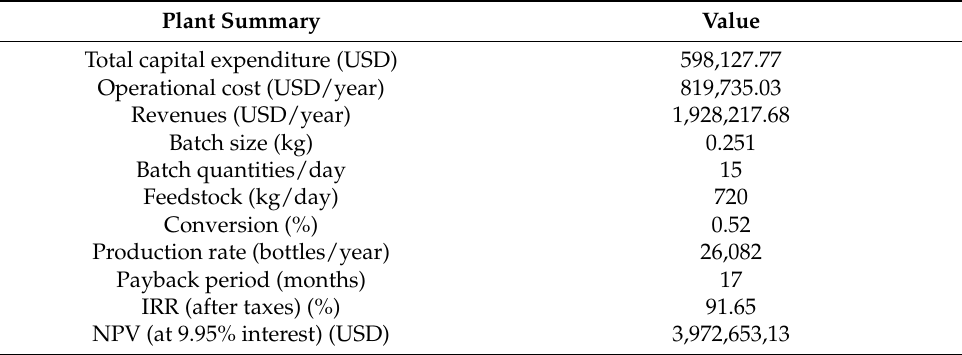
Table 4. Economic summary of longevity spinach extract